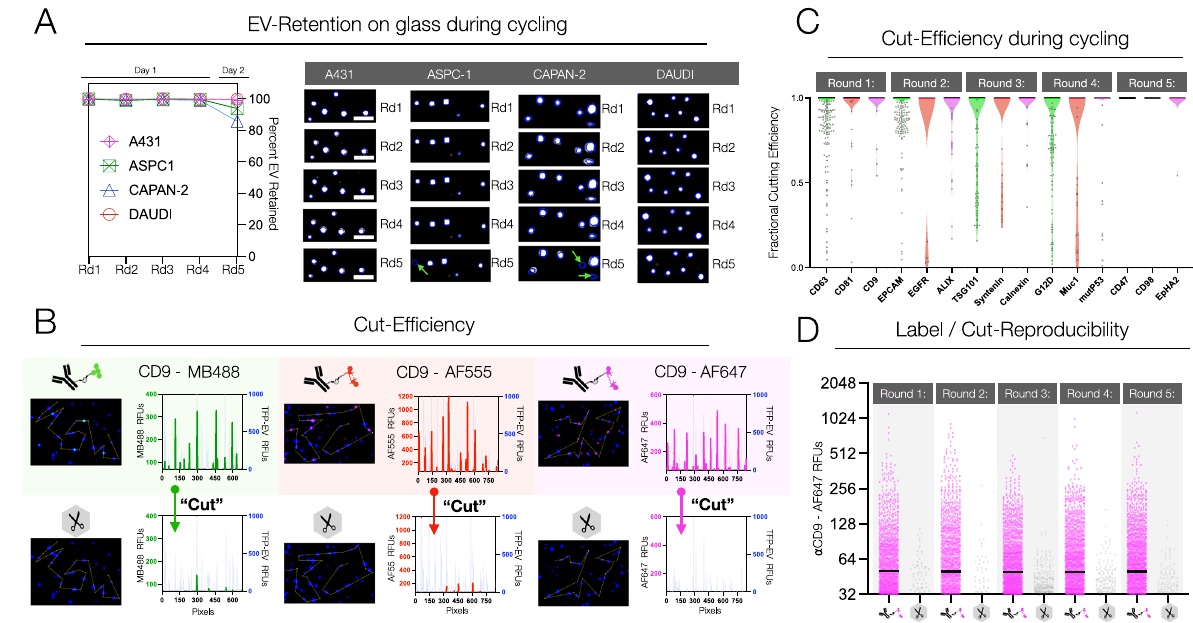
Fig. 2 | Characterization of the MASEV method. A Retention of EV within glass slide chambers. Multiple cell line EV were adhered to the treated glass and sub- jectedto5roundsofMASEVcyclingusingapanelof15antibodies.EVretentionwas determined by the presence of a TFP-EV signal remaining within the TFP-EV ROI generated at round 1. Only when cycling was resumed after 12h (for round 5) was anyappreciablelossofEVnoted,and>80%ofEVwereretainedevenover2daysof imaging ( N =1000 EV, scale bar 10 μ m). B CD9 conjugated with C 2 TCO-MB488, C 2 TCO-AF555, and C 2 TCO-AF647 fl uorophores were used to stain PANC-1 EV. All three fl uorophores were effectively cut using tetrazine (Tz) scissors, as